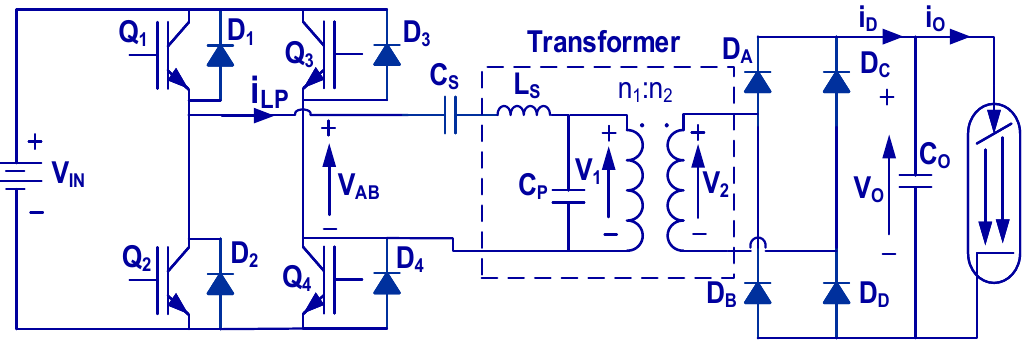
Figure 1. Series–parallel resonant topology, PRC-LCC, with a capacitor as output filter.